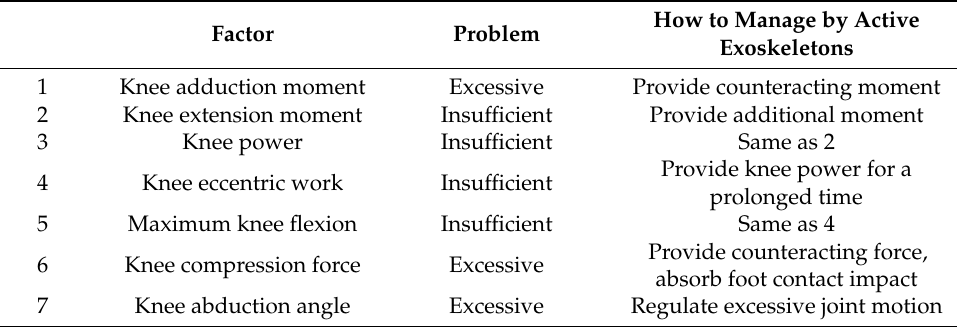
Table 1. Summary of knee biomechanical parameters and potential application of active knee orthosis